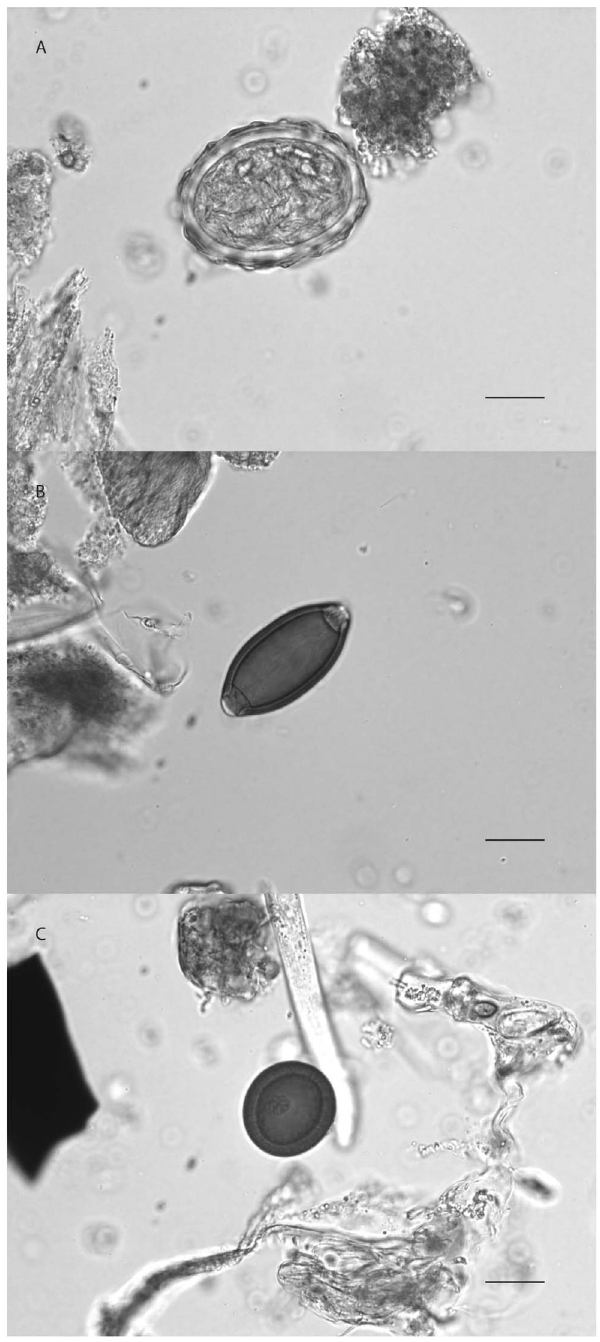
Figure 2. A. Egg of Ascaris lumbricoides (66.57 6 53.04 m m) recovered in individual # 1018 in Carspach ‘‘Kilianstollen’’. B. Egg of Trichuris trichiura (53.19 6 27.45 m m) recovered in individual # 1019 in Carspach ‘‘Kilianstollen’’. C- Egg of Taenia sp. (34.95 6 32.25 m m) recovered in individual # 1018 in Carspach ‘‘Kilianstollen’’. Scale bar=20 m m (Photos: M. Le